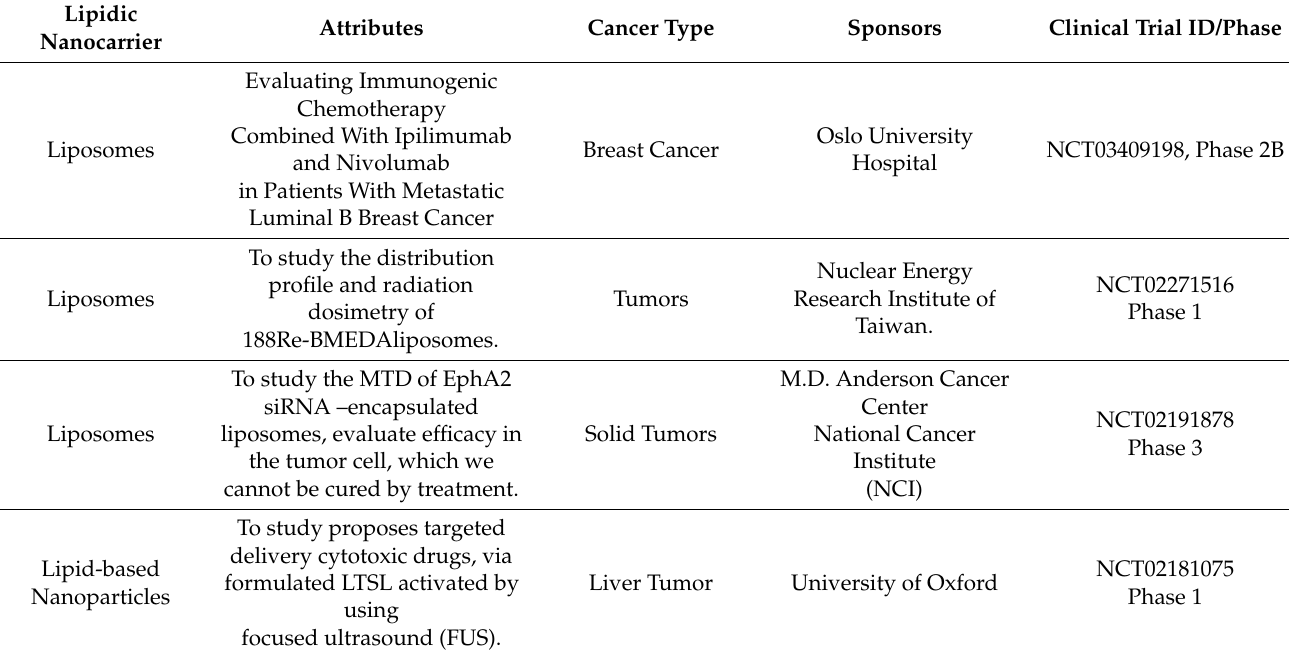
Table 2. Lipidic nanocarrier based cancer theranostic in clinical stage of